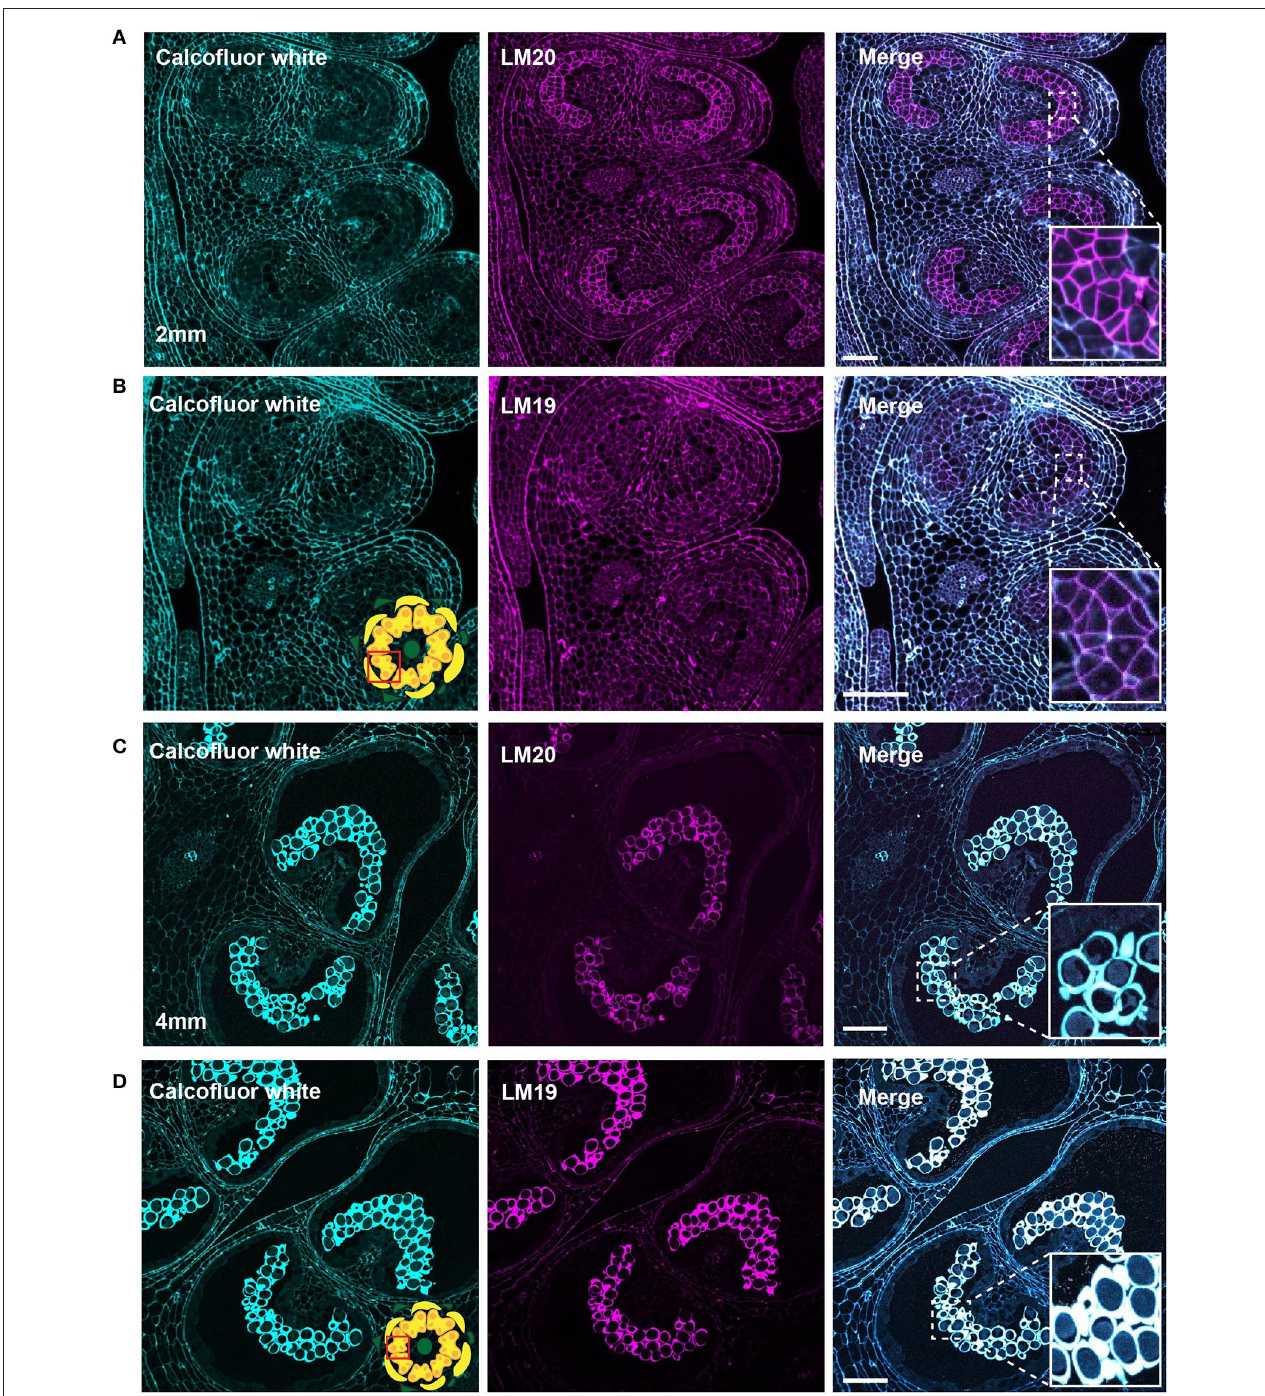
FIGURE 6 | LM20 and LM19 immunostaining of the 2-mm and 4-mm bud anthers. Fluorescent micrographs of anther cross sections (500nm) in LR white, of the 2-mm and 4-mm bud anther, stained with Calcofluor white and FITC conjugated anti-rat secondary for LM20 or LM19. Calcofluor white staining (Cyan) (left). Aniline blue staining (magenta) (center). Merged staining (right). (A) LM20 staining of the 2-mm anther. The right panel inset, showing zoomed-in view of the MMCs wall with the merged staining. (B) LM19 staining of the 2-mm anther. The right panel inset, showing zoomed-in view of the MMCs with the merged staining. (C) LM20 staining of the 4-mm anther. The right panel inset, showing zoomed-in view of the tetrad cells with the merged staining. (D) LM19 staining of the 4-mm anther. The right panel inset, showing zoomed-in view of the tetrad cells with the merged staining. Scale bars 50 µ m.